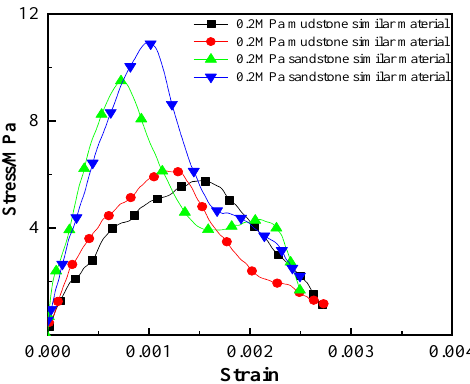
Table 5. Results of dynamic splitting experiments for similar materials.